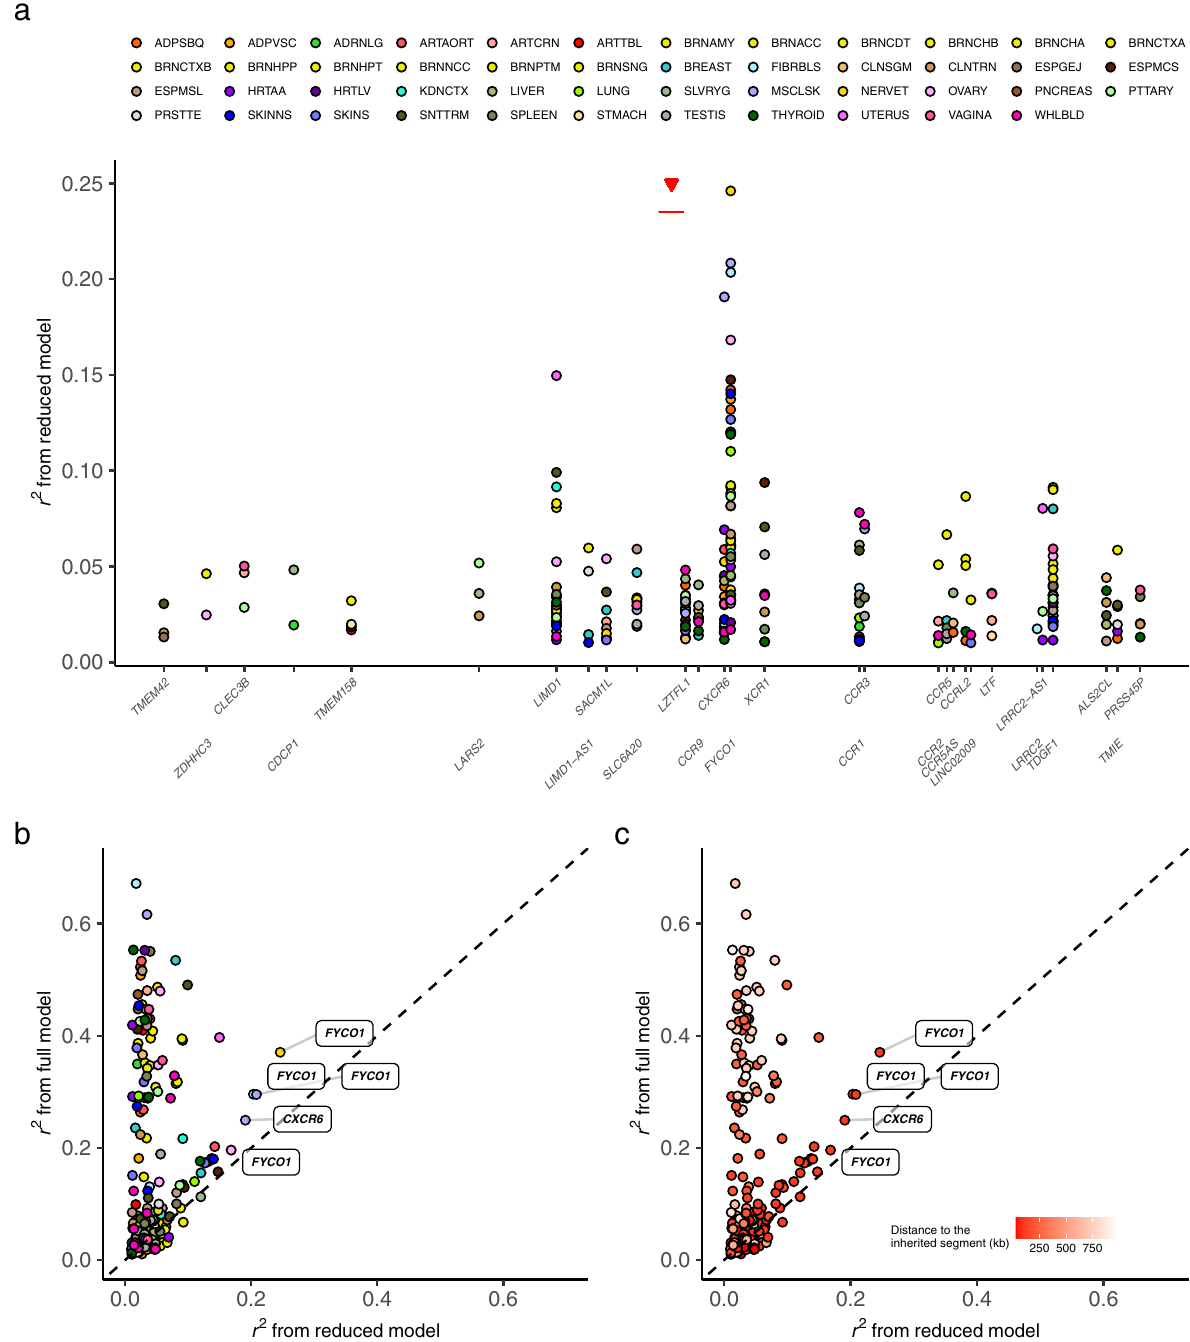
Fig. 2 Segment-based gene expression heritability. We generated JTI gene expression prediction models in each of the 49 tissues (GTEx v8), using SNPs in the 49.4 Kb introgressed segment (whose position is marked by a red segment under a triangle in panel ( a )) and estimated the prediction performance ( r 2 ) using fi ve-fold cross-validation. Imputable genes ( r > 0.1 and P < 0.05 in cross-validation; “ Methods ” ) are shown in panel ( a ), where the y -axis presents the prediction performance. Panels b and c show the performan c e comparison between ‘ full ’ model and ‘ reduced ’ model. The ‘ full ’ model was trained using SNPs within 1 Mb of both sides of the gene body. The ‘ reduced ’ model used only SNPs in the introgressed segment (same as panel ( a )). Panels ( b ) and ( c ) are colored according to the tissue and the distance to the segment, respectively. Highly imputable genes ( r 2 > 0.15) based on the reduced model are labeled in panels ( b ) and ( c Based on the estimate from JTI, the segment explained up to robust to model misspeci fi cation than the standard genome- 24.6%, i.e., for FYCO1 , of the variance in gene expression in the based restricted maximum likelihood (GREML) approach ( “ Meth- locus (Fig. 2a). Interestingly, the protein FYCO1 was recently ods ” ), which assumes a polygenic architecture. In this study, for shown to physically interact with SARS-CoV-2 ’ s NSP13, a helicase- heritability, we consider only the proportion of gene expression triphosphatase, in a study 14 of protein interaction map between variance explained by cis regulation (Fig. 1).